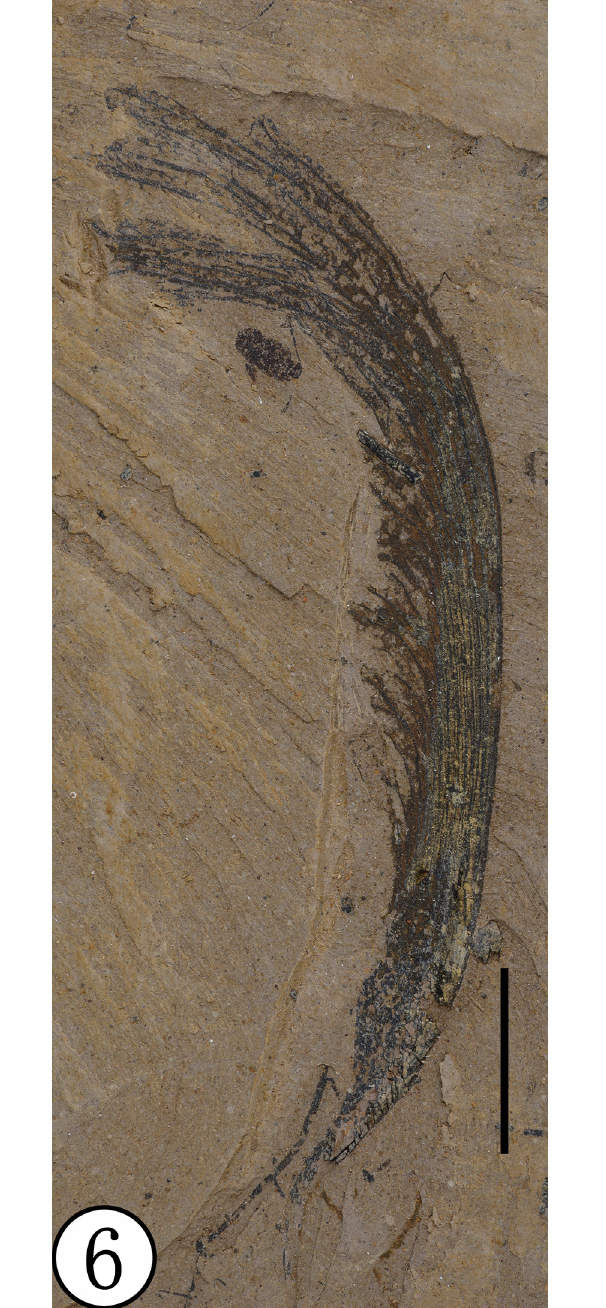
Fig 6. Paratype (NHMG030167), preserved at the Guangxi Museum of Natural History, China. Scale bar = 1 cm. the dorsal margin for some distance then arching distally toward the ventral margin, with rela- margin of the wing. The stipe is at least 2mm long, without an obvious perianth scar at its base. A small projection about 1.5 mm long is present on the nut opposite the attachment end.